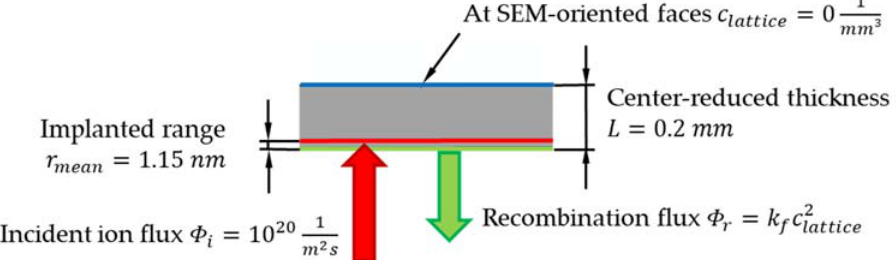
Figure 2. RD boundary conditions of the one-dimensional (1D) hydrogen permeation model. The time history of the sum of the incident ion flux and the recycling flux is applied as boundary condition at the H charging area in the three-dimensional (3D) model.